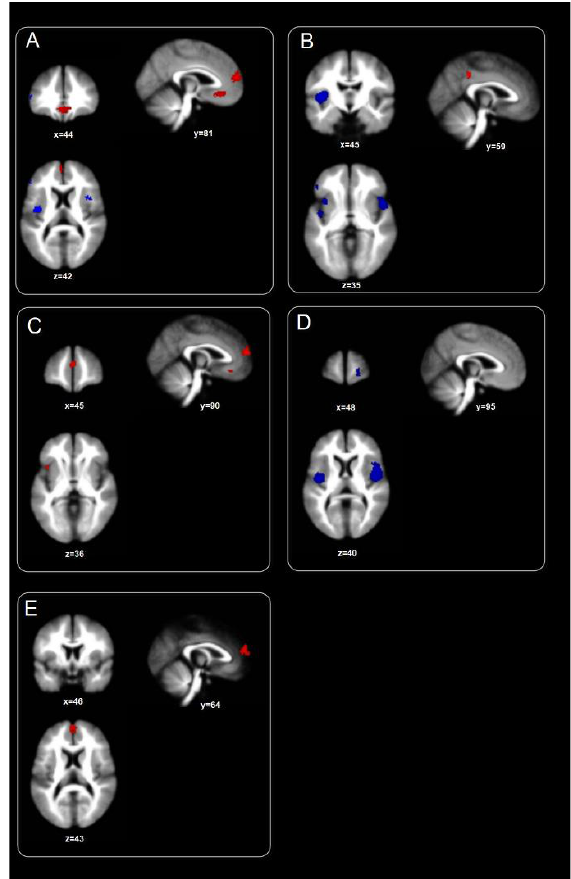
Figure 2. The figure depicted the meta-analysis results according to the subdivision performed and described in the methods. ( a ) Global results in which all the studies have been considered; ( b ) PE studies; ( c ) PED results; ( d ) resting state studies ( e ) task-based studies. Maps are in neurological convention and are over-imposed on MNI templates. Table 4. Talairach coordinates Z and P values of the clusters as calculated for each map.